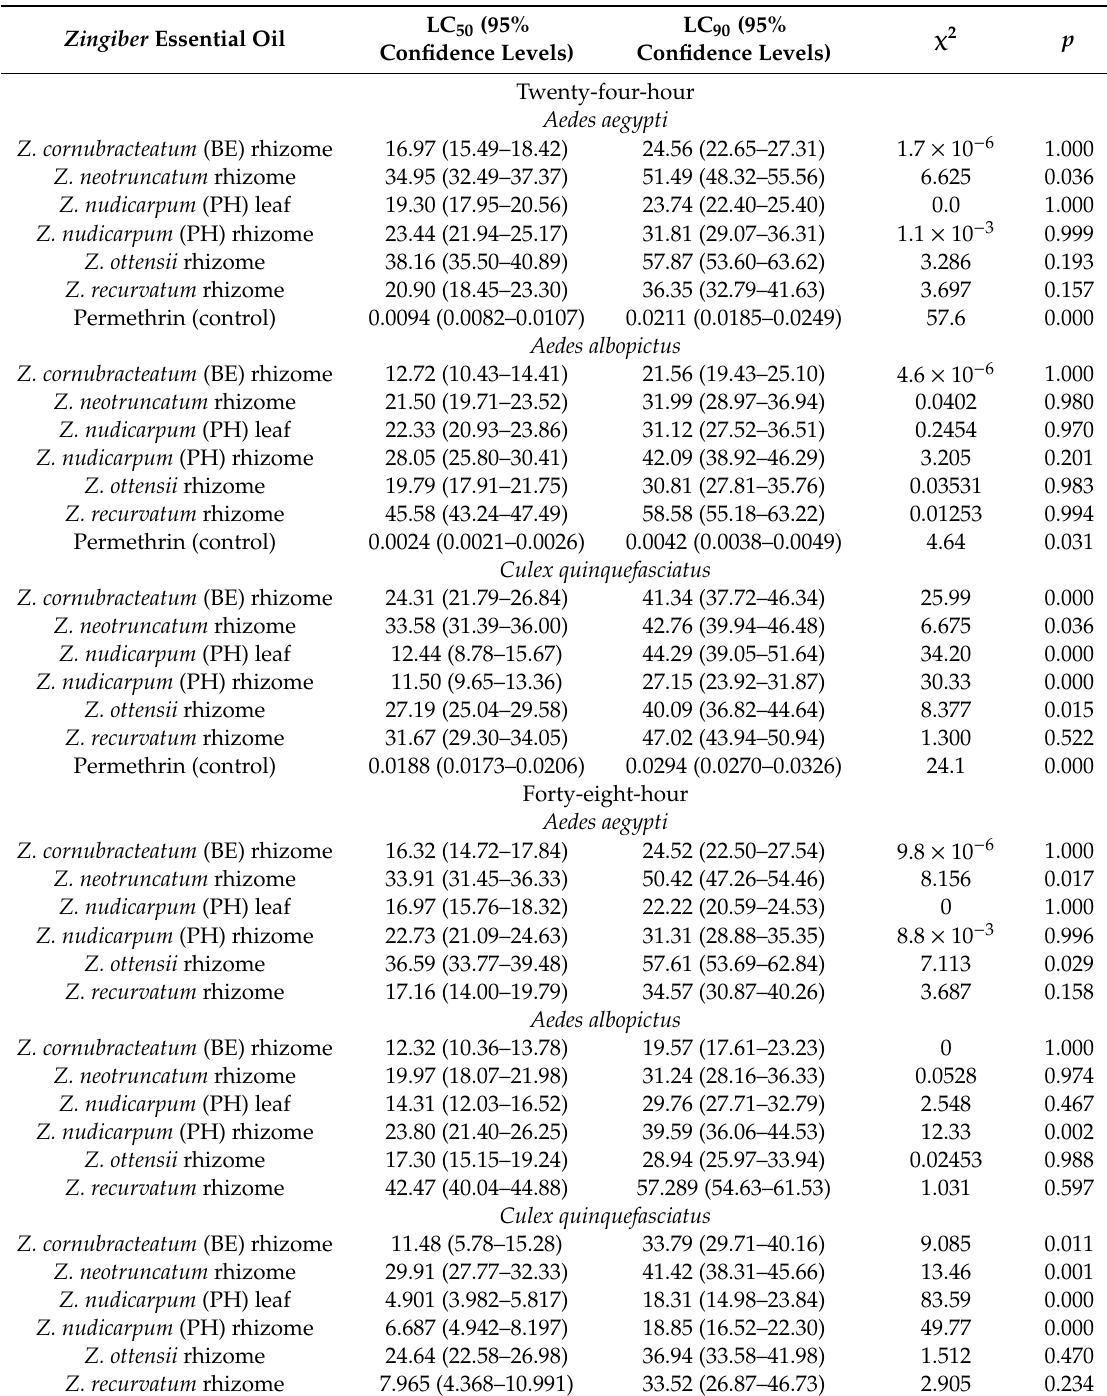
Table 5. Larvicidal activities of Zingiber essential oils from north-central